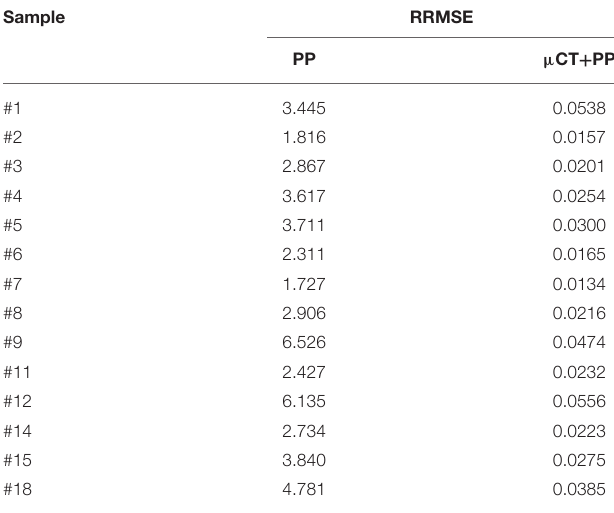
TABLE 5 | Relative root mean squared error (RRMSE, %) for the predicted soil water retention curves with the pressure plates data (PP) or the µ CT data plus the pressure plates data ( µ CT + PP) for the calibration data set samples.